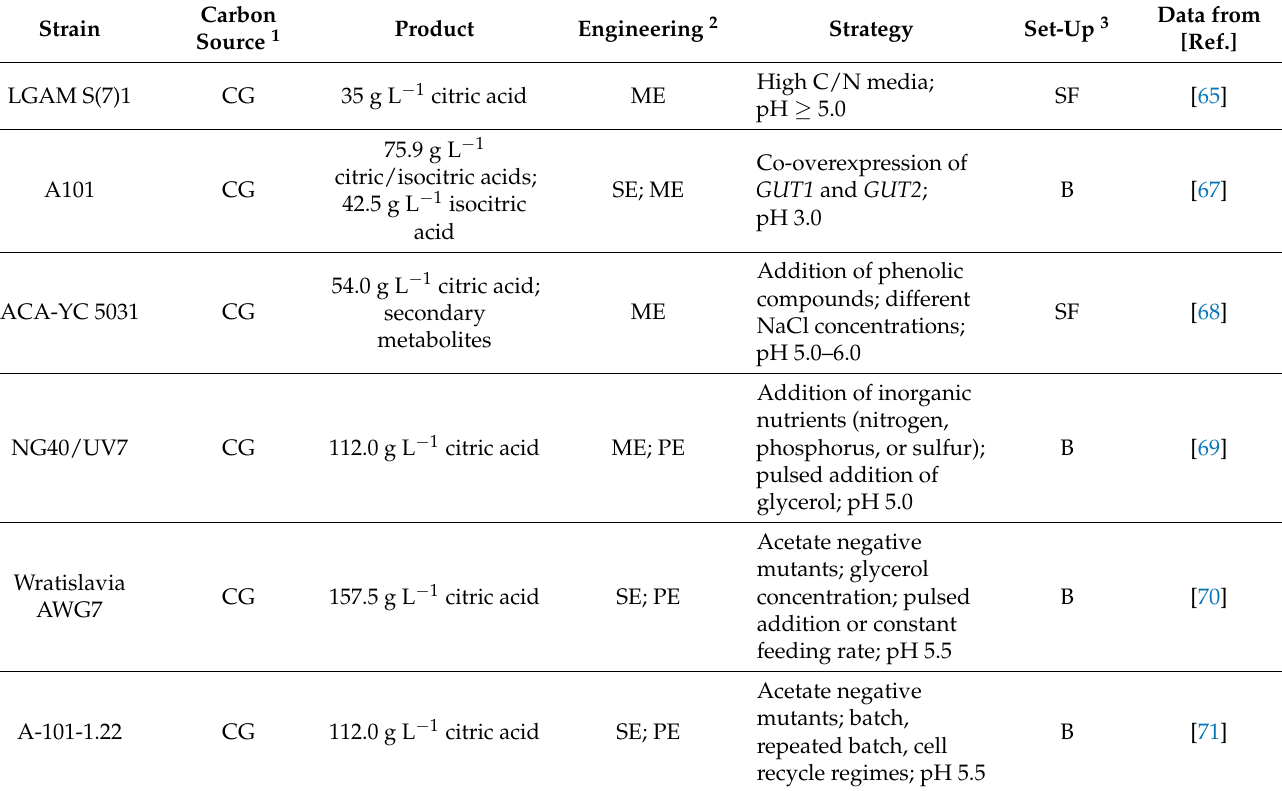
Table 2. Engineering strategies (strain, medium, process) and cultivation systems using pure or crude glycerol as carbon source for the production of citric acid by Y. lipolytica .